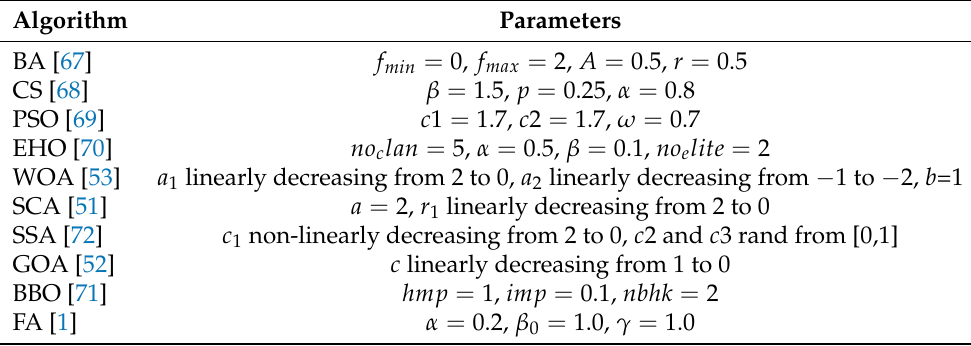
Table 17. Control parameter setup for metaheuristics included in the analysis.